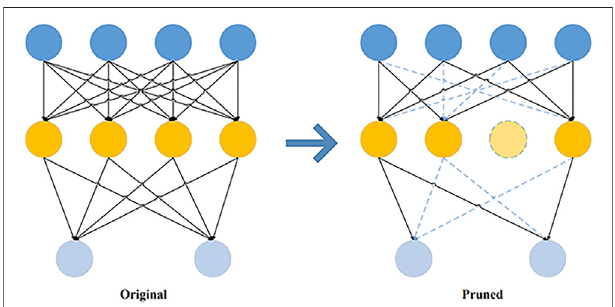
FIGURE 1 | Unstructured pruning diagram.